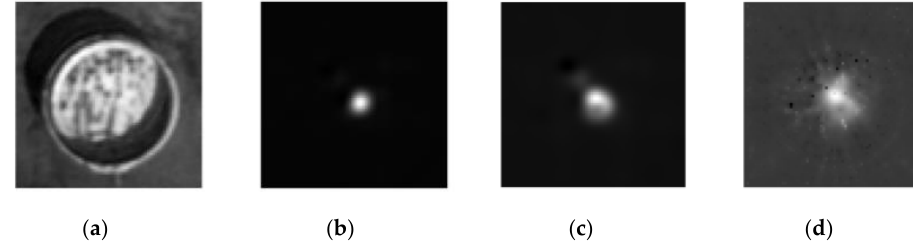
Figure 7. Comparison of results. ( a ) Original image; ( b ) when the radius is 23.5; ( c ) when the radius range is [20,27]; ( d ) when the radius range is [1,34].